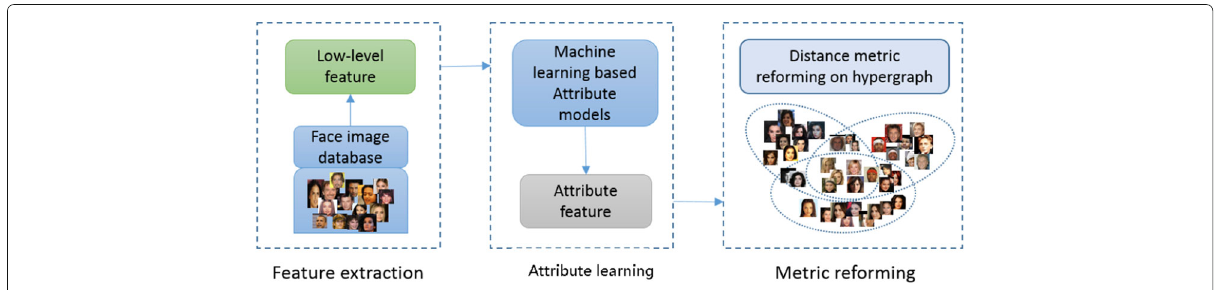
Fig. 2 The flowchart of improved hypergraph learning framework for metric learning